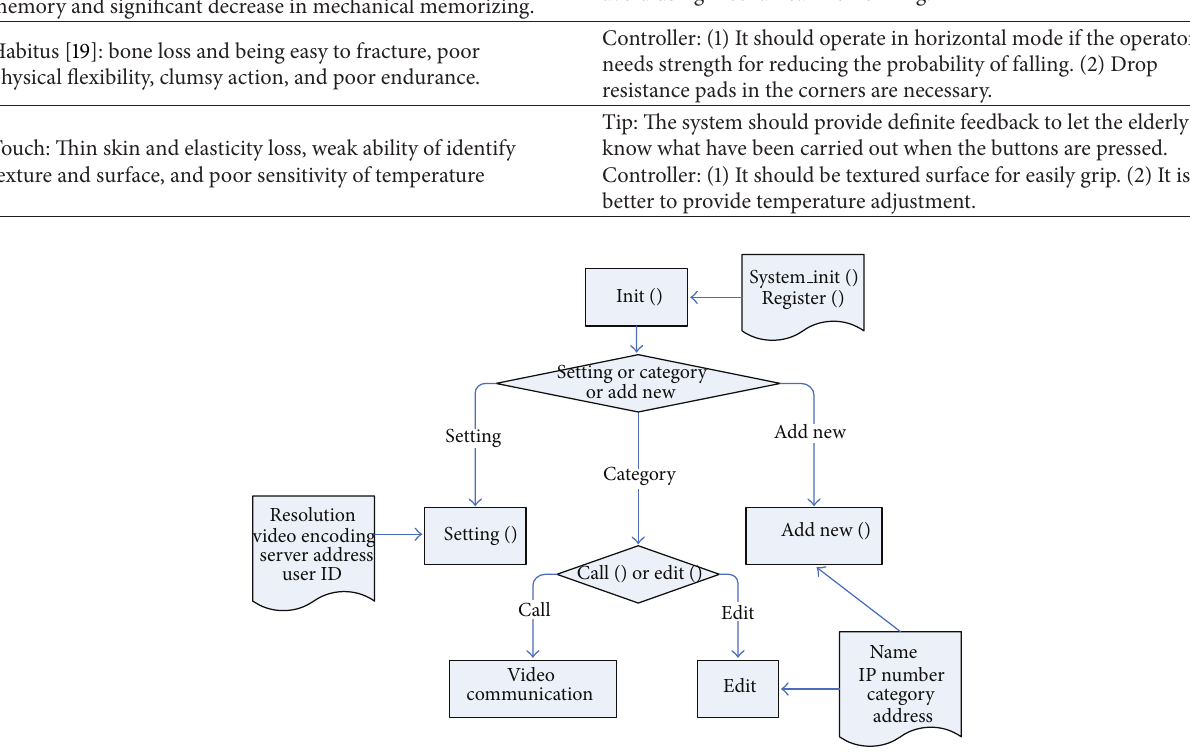
Figure 4: The architecture of